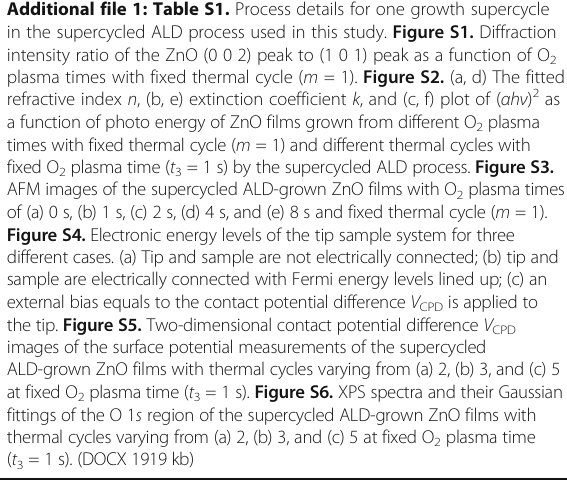
Figure S4. Electronic energy levels of the tip sample system for three different cases. (a) Tip and sample are not electrically connected; (b) tip and sample are electrically connected with Fermi energy levels lined up; (c) an external bias equals to the contact potential difference V CPD is applied to the tip. Figure S5. Two-dimensional contact potential difference V CPD images of the surface potential measurements of the supercycled ALD-grown ZnO films with thermal cycles varying from (a) 2, (b) 3, and (c) 5 at fixed O 2 plasma time ( t 3 = 1 s). Figure S6. XPS spectra and their Gaussian fittings of the O 1 s region of the supercycled ALD-grown ZnO films with thermal cycles varying from (a) 2, (b) 3, and (c) 5 at fixed O 2 plasma